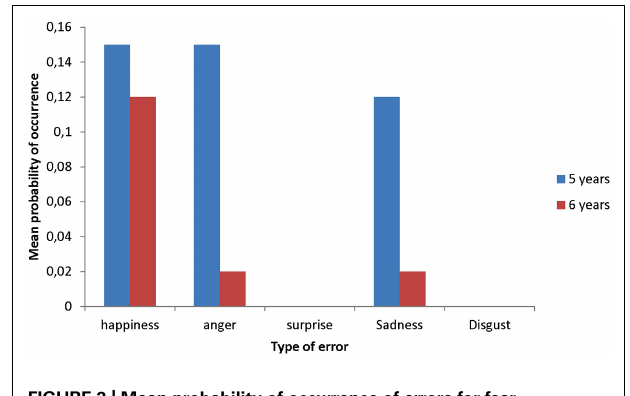
FIGURE 2 | Mean probability of occurrence of errors for fear expressions as a function of type of error.